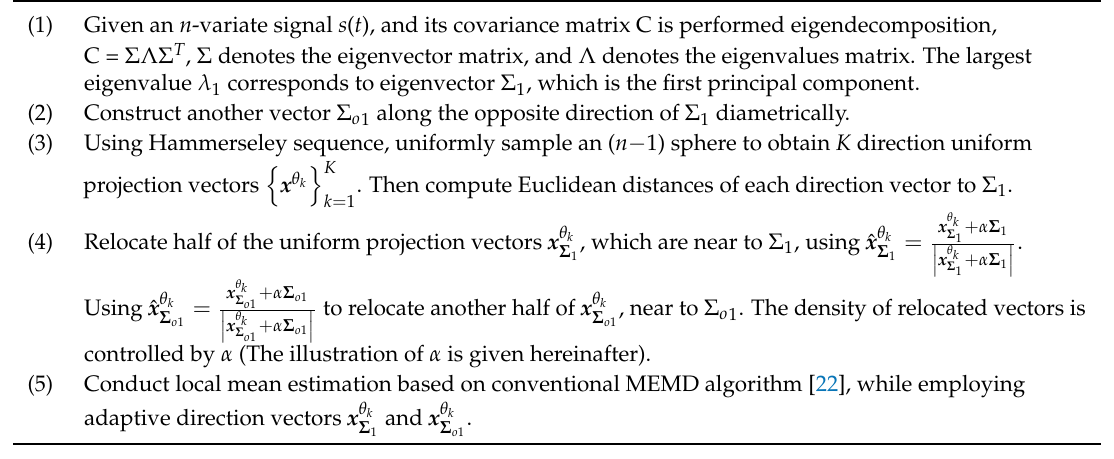
Table 1. The detailed procedures of